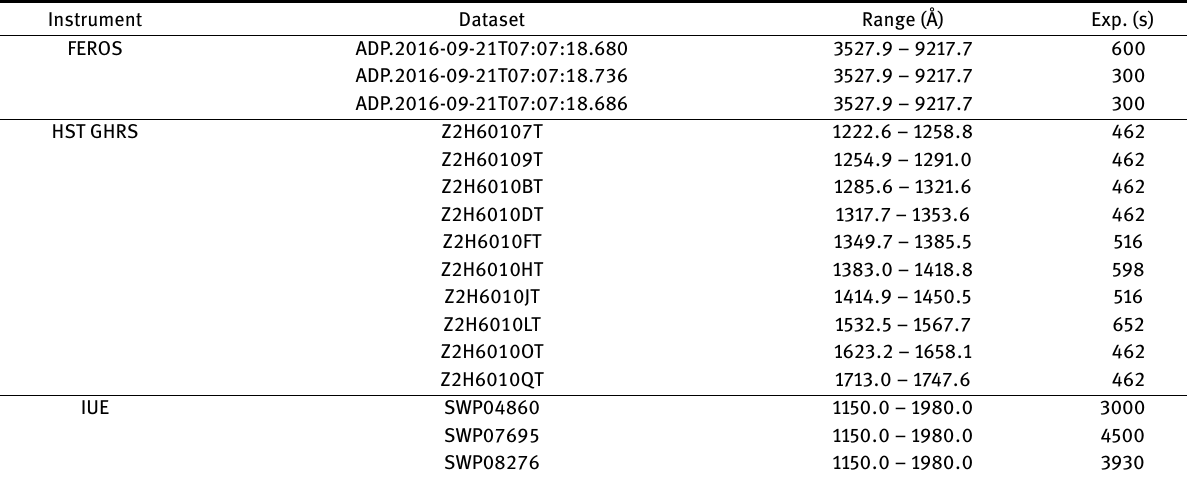
Table 1. List of observations used in our analysis. Instrument